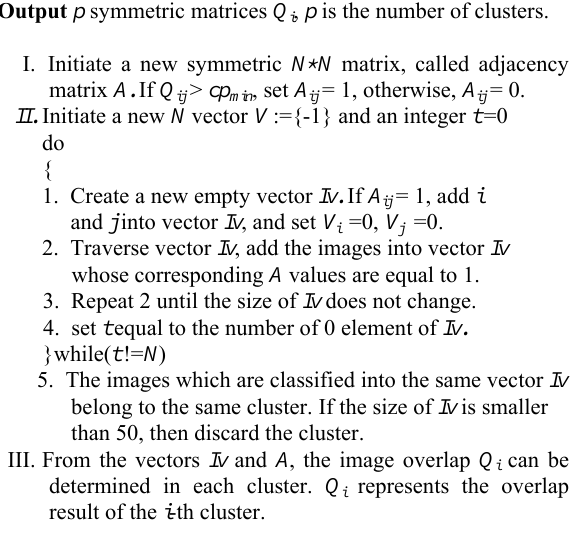
Algorithm 1 Clustering images and discarding single